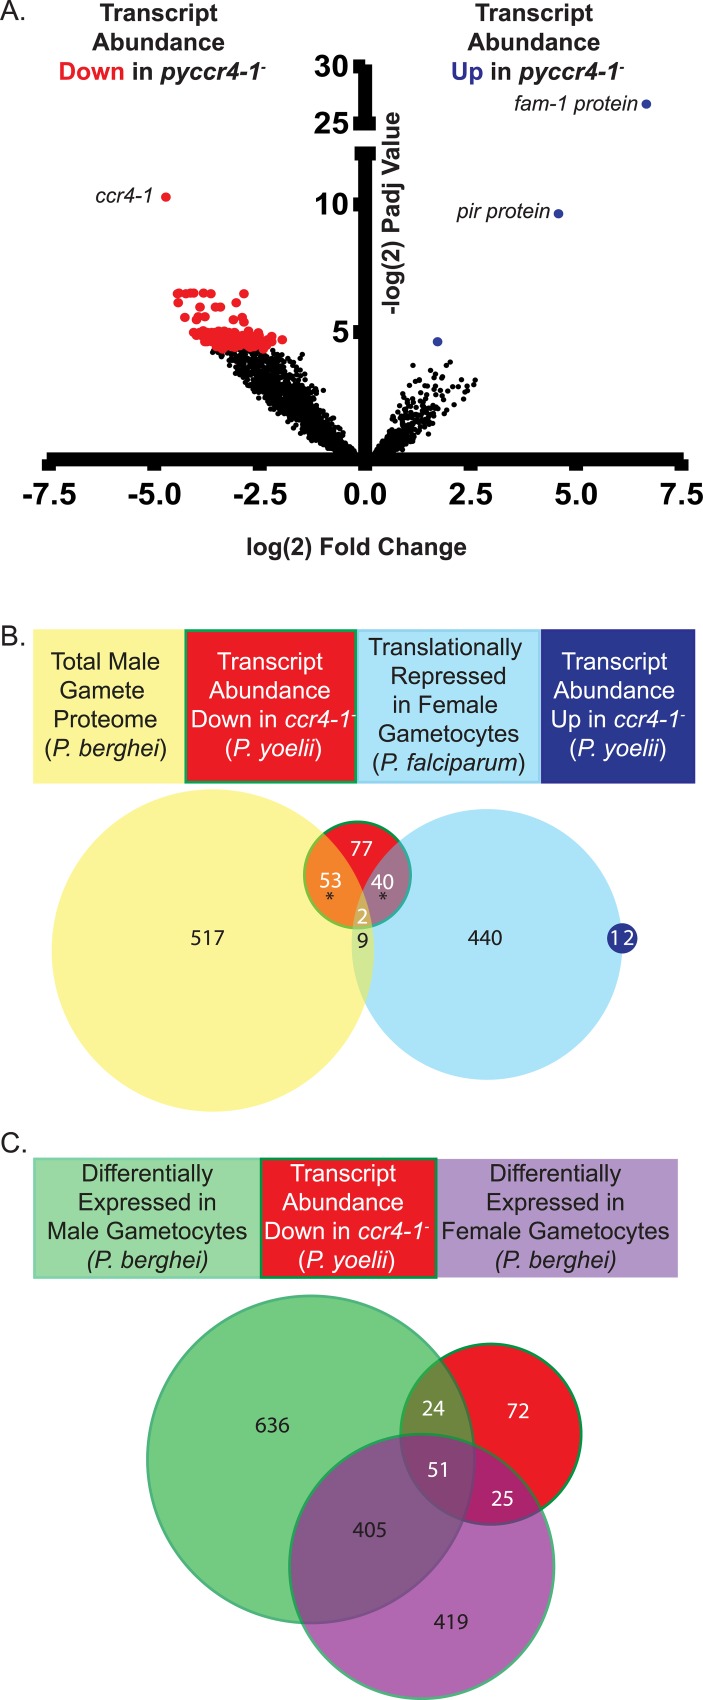
Transcripts with sex-specific or transmission-related functions are modulated by PyCCR4-1.A) A volcano plot showing statistically significant increases (blue), decreases (red), or no change (black) is provided. While few transcripts go up in abundance (from antigenically variant genes), nearly all affected transcripts decrease in abundance, thus indicating that PyCCR4-1 may play a role in preserving these mRNAs. B) In pyccr4-1- gametocytes, 24% of differentially abundant transcripts are translationally repressed in female P. falciparum gametocytes and another one third of the transcripts are enriched in the male P. berghei gamete proteome [50, 69]. * = p<0.01 by Fisher test. C) In pyccr4-1- gametocytes, transcripts that are differentially expressed in male and female P. berghei gametocytes are equally affected.